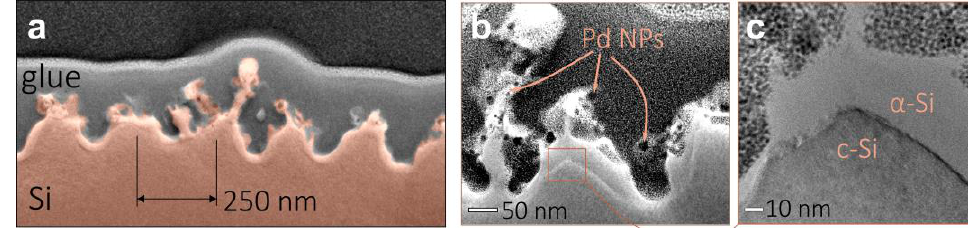
Figure 2. ( a ) SEM image of the cross-sectional cut of the Si nanograting morphology ( F = 0.1 J/cm 2 , v = 100 µm/s, k = 1 KHz) decorated with Pd NPs. ( b ) Close-up TEM image of the isolated surface protrusions with the Pd NPs. ( c ) TEM image showing amorphisation of the textured Si surface.